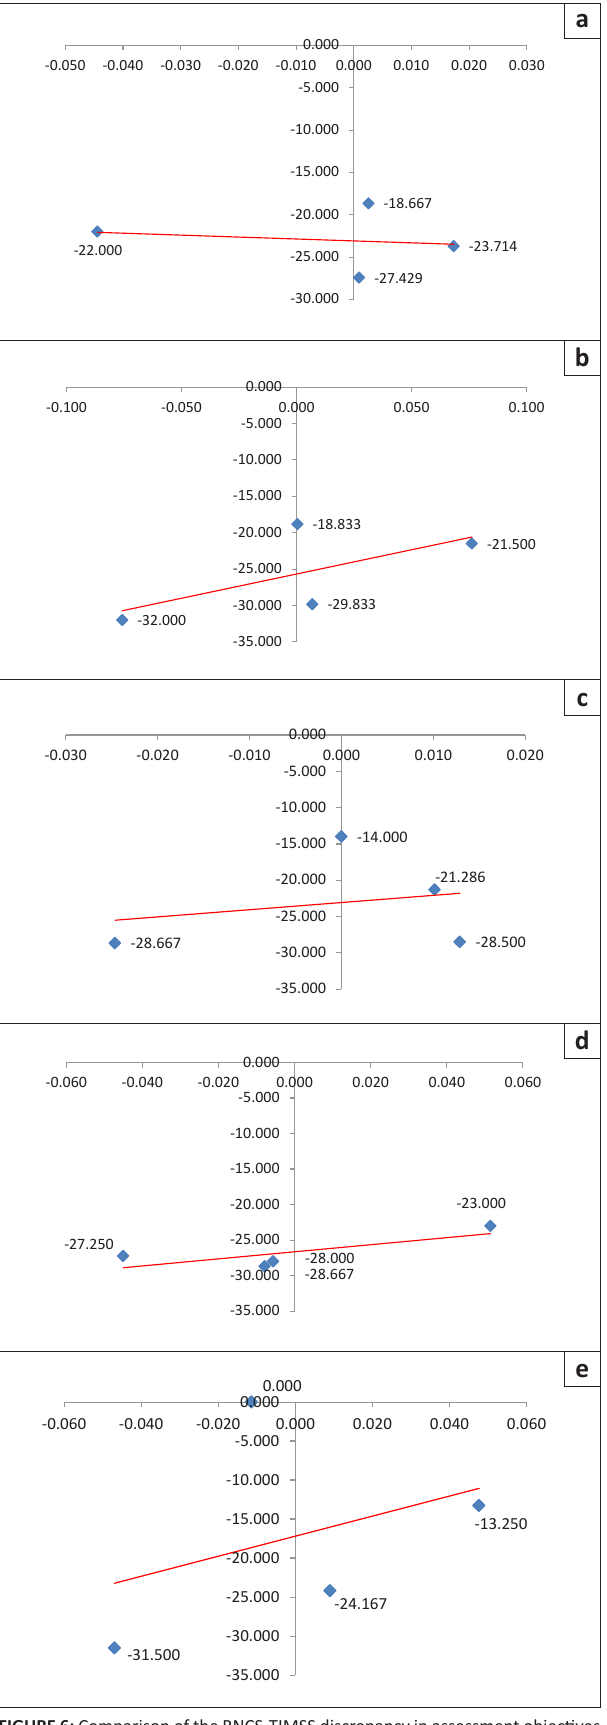
FIGURE 6: Comparison of the RNCS-TIMSS discrepancy in assessment objectives and SA students’ performance in TIMSS 2003: (a) Number, (b) Algebra, (c) Measurement, (d) Geometry and (e)